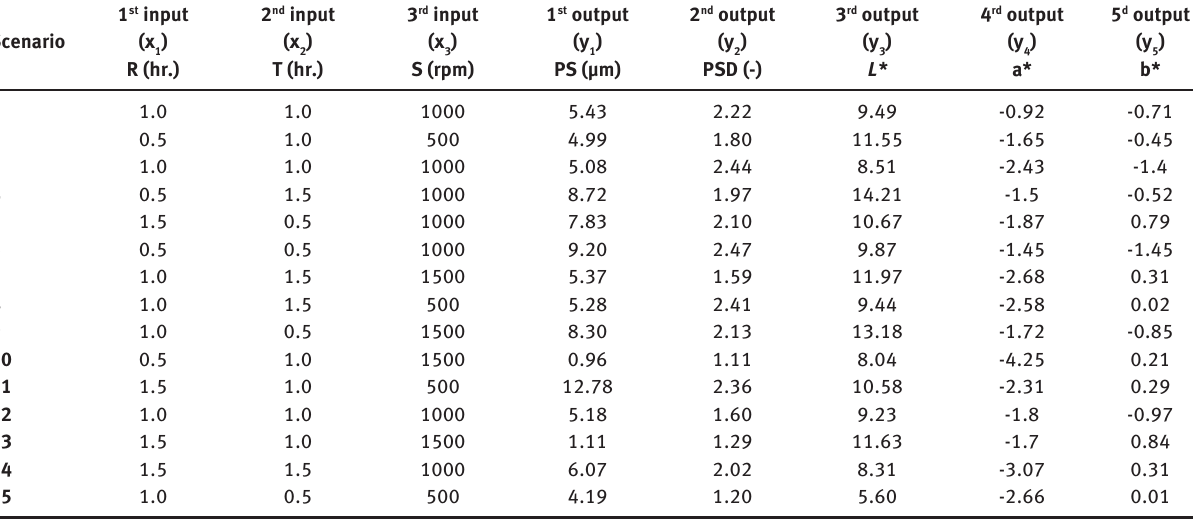
Table 1: Scenarios considered as internal data for the constructed model.